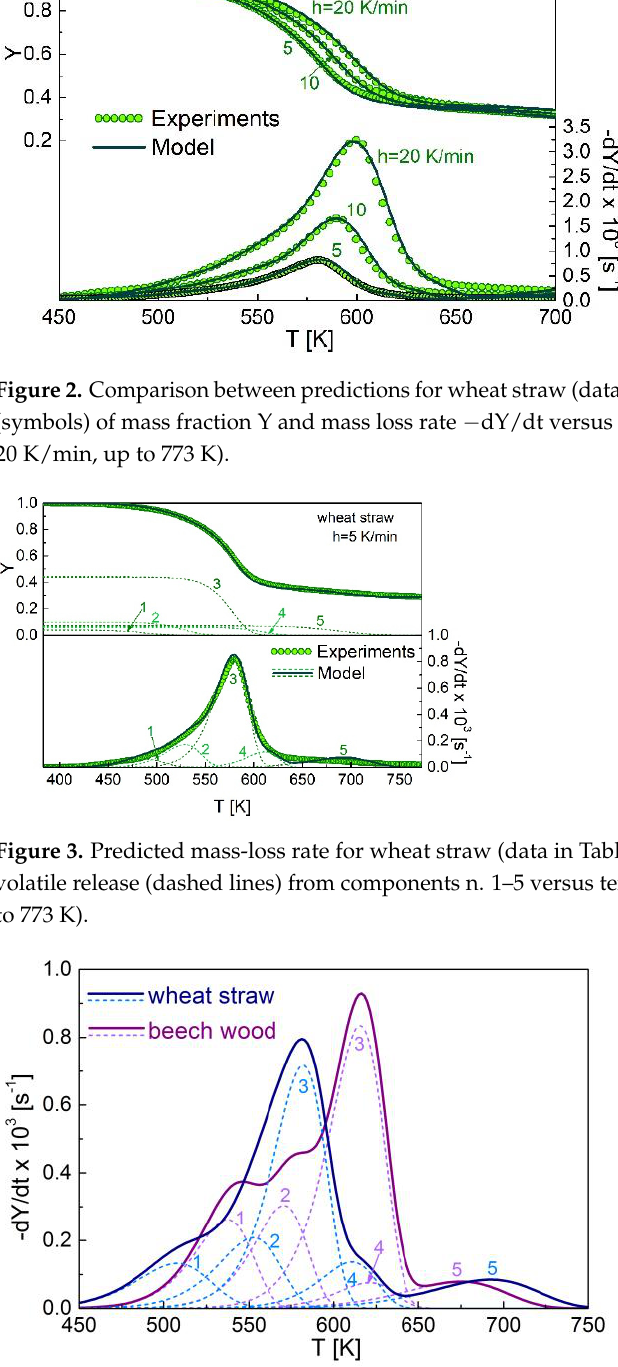
Figure 4. Predicted mass-loss rate for wheat straw and beech wood [22] (data in Table 2A,B), − dY/dt and predicted rates of volatile release (dashed lines) from components n. 1–5 versus temperature (heating rate 5 K/min, up to 773 K).